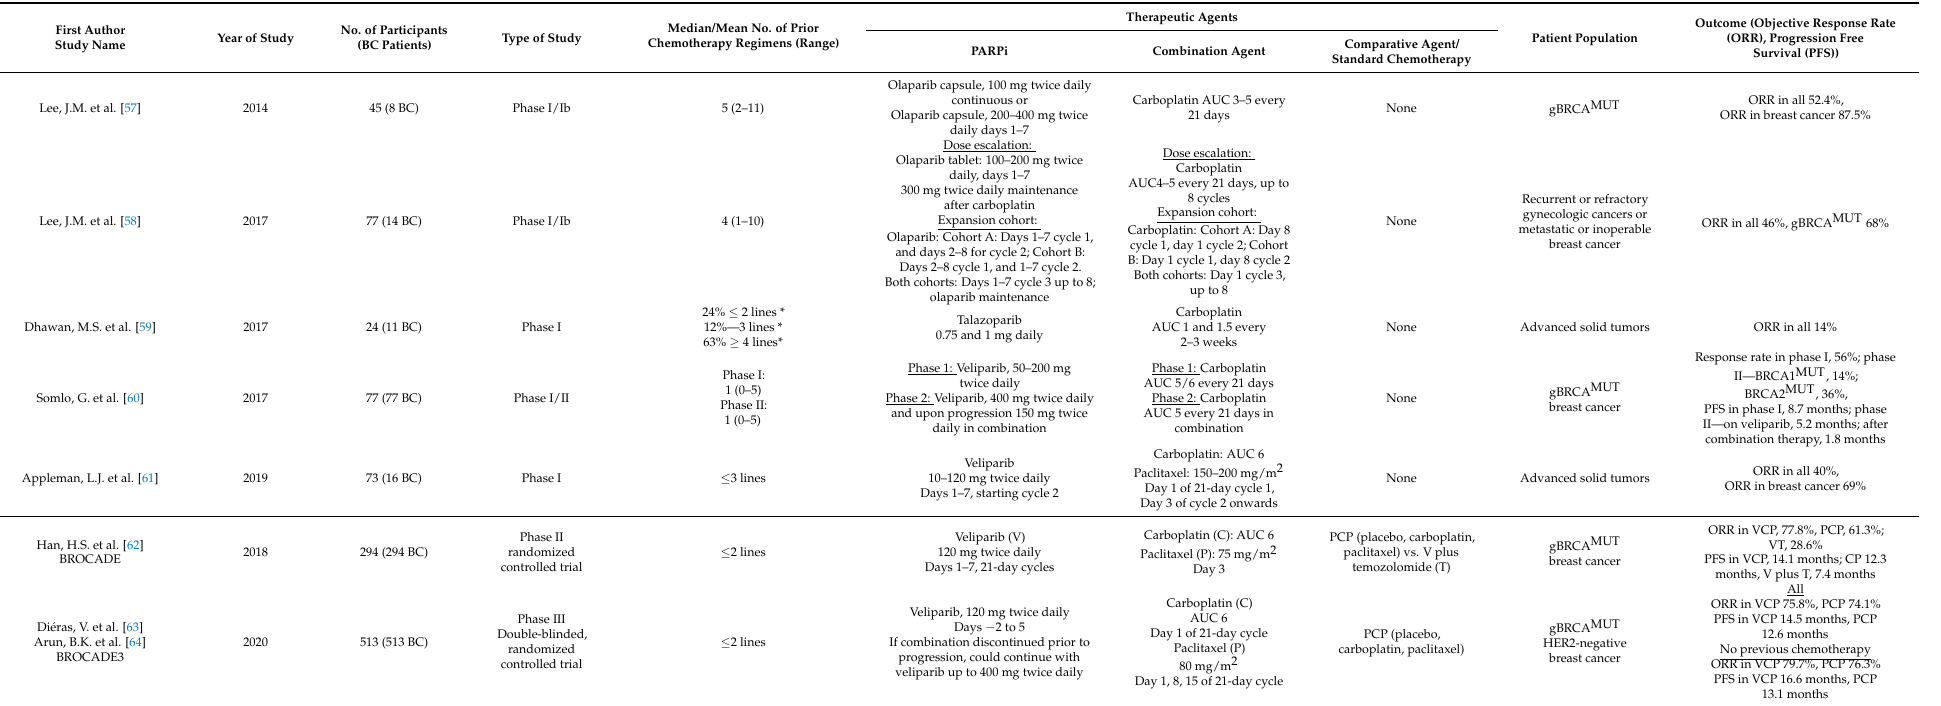
Abbreviations: BC, breast cancer. * Previous treatment